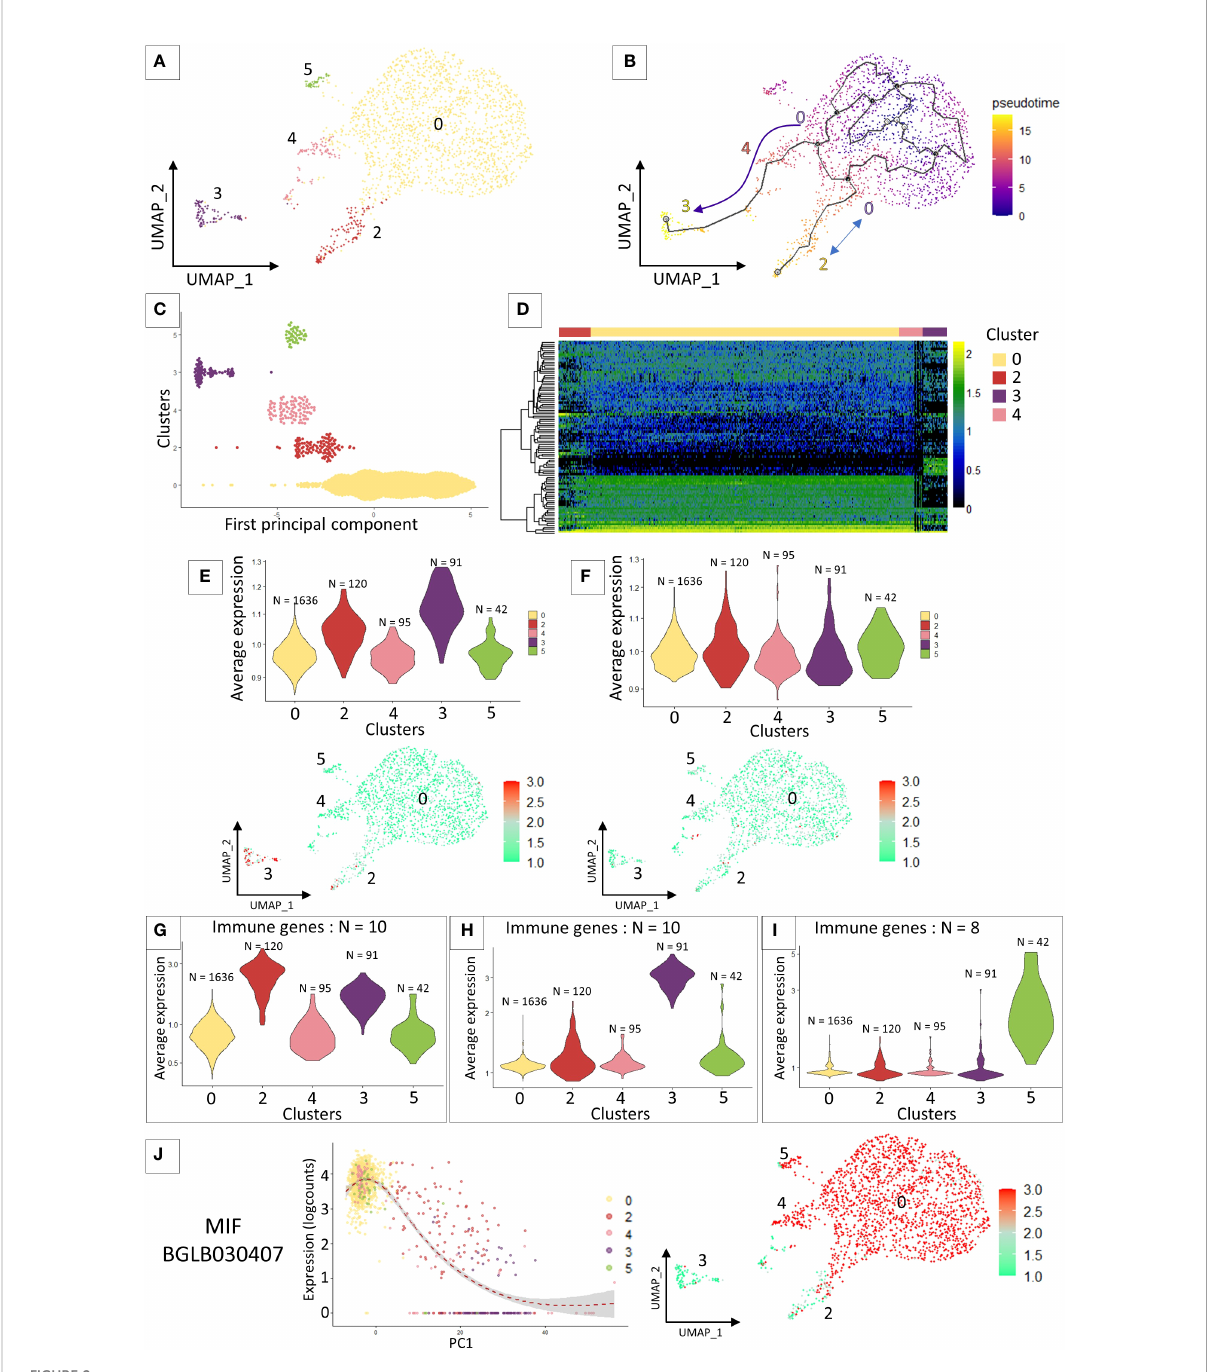
FIGURE 2 (A) UMAP representation of cluster 5 identi fi ed after removing clusters 1 and 6 from the previous analysis and performing reclustering. (B) Pseudo time analysis on the UMAP representation. Arrows represent the direction of the possible differentiation process between the different transcriptomic clusters. (C) Dotplot of the cluster cells ordered along the pseudo time. (D) heatmap representing the expression of the 100 most variable genes that characterized the pseudo-time analysis across the 4 clusters. (E) and (F) VlnPlot and UMAP representation of the average expression of marker genes from the literature. (E) represents granulocyte marker genes and (F) represents hyalinocyte marker genes. (G, H) and (I) Average expression of an immune gene set belonging to different “ activated ” clusters such as cluster 2 (G) , cluster 3 (H) and cluster 5 (I) . (J) Expression of the MIF gene along the pseudo-time (left graph) and the representation of its expression by the different cells of the analysis on the UMAP representation (right